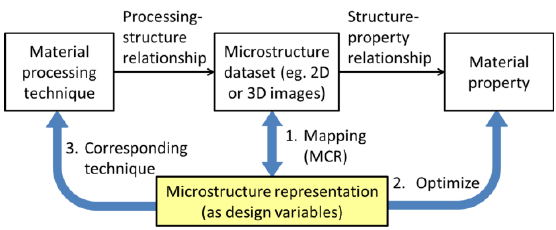
Figure 5. Framework for design of advanced material systems (MCR refers to microstructure characterization and reconstruction).